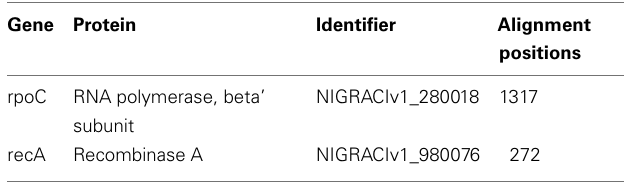
TableA1 | Proteins used for